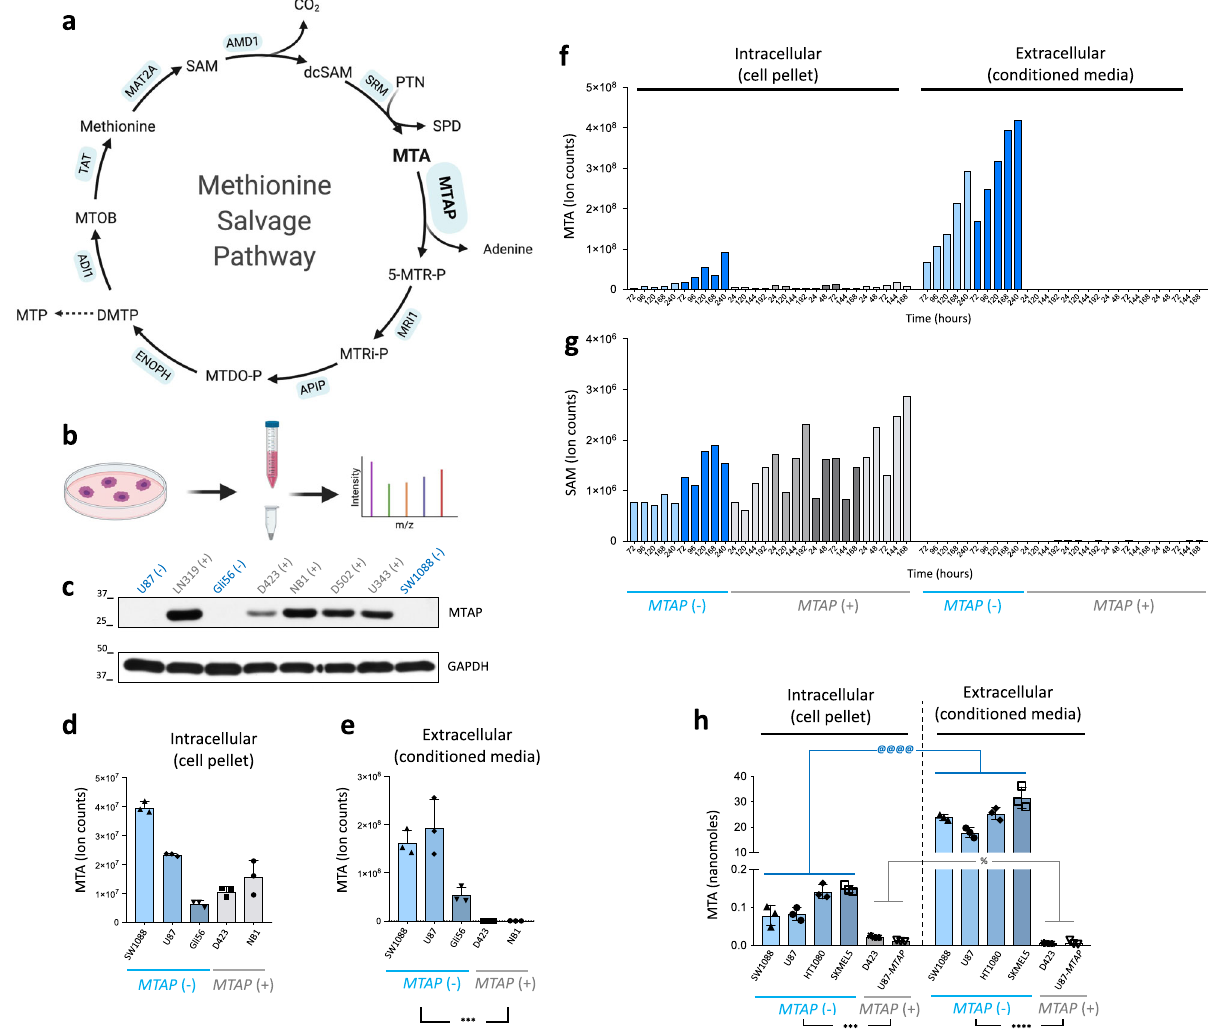
Fig. 1 Dramatic elevation of MTA in conditioned medium of MTAP -deleted cells versus WT coupled with mild intracellular elevation. a The methionine salvage pathway (based on KEGG 68 ) with most genes are housekeeping expressed broadly across cell lines and tissues (DepMap, The Human Protein Atlas). SAM S -adenosylmethionine, dcSAM S -adenosylmethionineamine, MTA methylthioadenosine, SPD spermidine, PTN putrescine, MTOB 4- methylthio-2-oxobutanoate, DMTP 1,2-dihydroxy-5-(methylthio)pent-1-en-3-one, MTP 3-(methylthio)propanoate, MTDO-P 5-(methylthio)-2,3- dioxopentyl-phosphate, MTRi-P S-methyl-5-thio- D -ribulose-1-phosphate, 5-MTR-P methylthioribose-1-phosphate. b MTA levels were determined in conditioned media (extracellular) and washed cell pellets (intracellular) of homozygous MTAP -deleted ( MTAP − ) and wild-type ( MTAP + ) cells in culture. Color coding re fl ects the same cell line for pellet/media. c MTAP status of cell lines con fi rmed by western blot repeated independently twice. d , e Levels of MTA (mean + SD, N = 3 biological replicates) in a panel of glioma cell; washed cell pellet — intracellular ( d ) and conditioned media — extracellular ( e ). Note >200-fold increase in MTA in conditioned media of MTAP -deleted versus intact cell lines (*** p = 0.0005, unpaired two-tailed Student ’ s t test with unequal variance), while only marginal elevations are seen for this comparison in the cell pellet. f , g Time course of MTA levels in cell pellet and conditioned media ( f ) with SAM shown for comparison ( g ). x -axis: time of harvest after last media change; y -axis: ion counts for each metabolite. Each bar represents one biological replicate. There was a distinct, time-dependent increase in MTA in media of MTAP -deleted cells with a modest increase of MTA in the cell pellet. There was an imbalance of MTA in the pellet versus the media, contrasting what was observed with SAM, which is exclusively intracellular. h Absolute quanti fi cation of MTA in cell pellet and conditioned media (mean + / − SD, N = 3 biological replicates). The amount of MTA recovered from conditioned media of MTAP -deleted cells is 200-fold greater than recovered from the cell pellets. In contrast, in MTAP -WT cells, the amount of MTA in conditioned media is comparable to that in cell pellet. The modest intracellular accumulation of MTA (sixfold) in the MTAP -deleted cells compared to the WT cells is overshadowed by the increase of extracellular MTA. Signi fi cant values are indicated as **** p = 4 × 10 − 8 , *** p = 0.00006, @@@@ p = 10 − 12 , and % p = 0.02 using multiple t test with Bonferroni sharp contrast with the MTAP -WT cells, where a comparable secreted metabolites (Fig. 1f versus Fig. 1g). We further measured amount of MTA was recovered from media (extracellular) and the absolute amount (nanomoles) of MTA for a paired sample of the cell pellet (intracellular). Taken together, our fi ndings agree cell pellets and conditioned media. Figure 1h indicates that the with previous conclusions 19,29 that homozygous MTAP -deleted amount of MTA recovered from the conditioned media from MTAP -deleted cells cultured for 3 days is approximately 200 cells secret MTA resulting in signi fi cant extracellular accumula- times more than MTA recovered from the cell pellets. This is in tion of MTA.